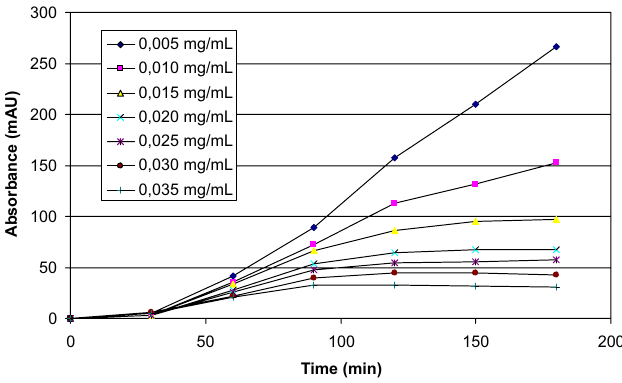
FIGURE 3 - Graph of microbial growth in tryptone soy broth inoculated with Escherichia coli (ATCC 8739) at 5% containing apramycin sulfate at various concentrations (5, 10, 15, 20, 25, 30 and 35 m g mL -1 ).